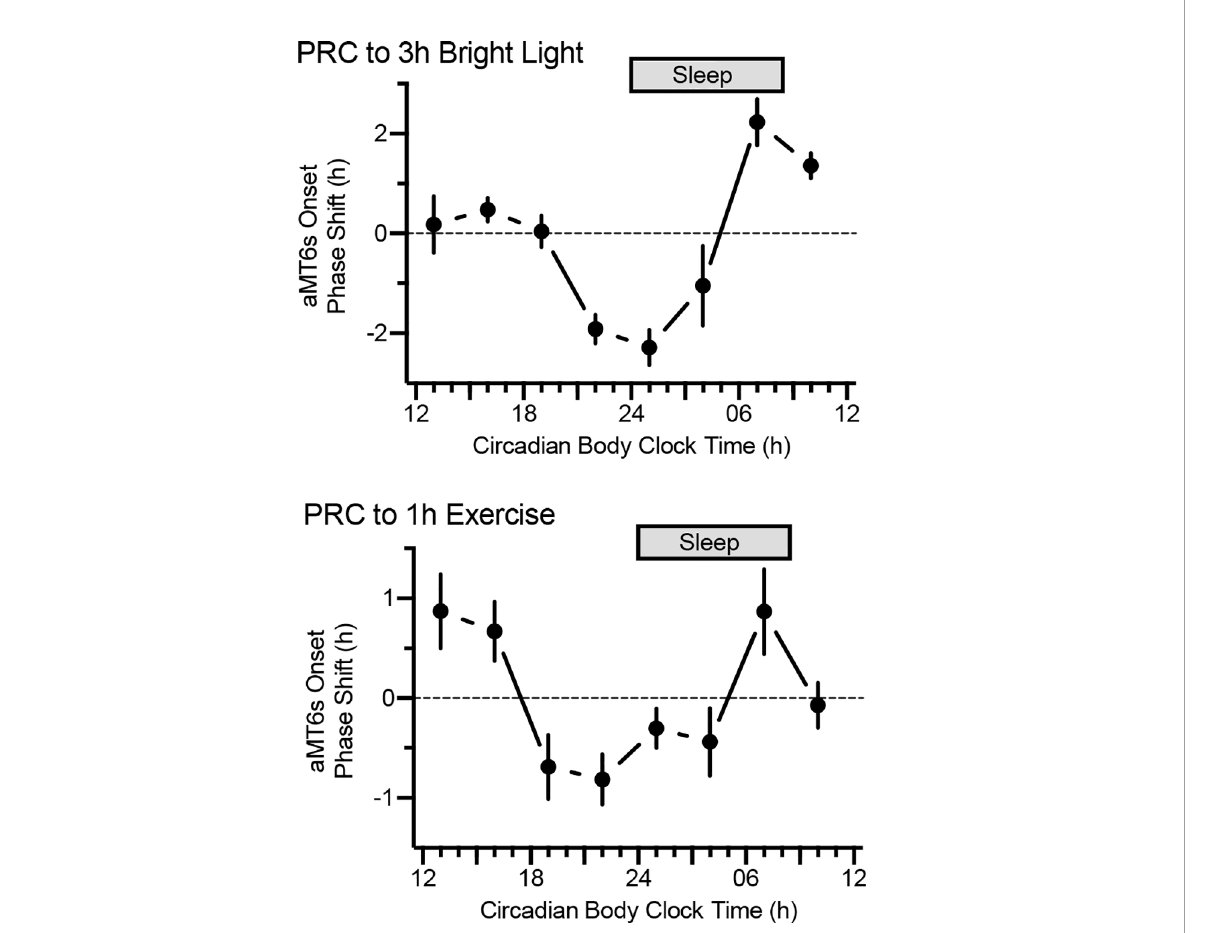
FIGURE 3 Phase-response curves to bright light (n = 105, top) and exercise (n = 101, bottom). By convention, phase advances and phase delays are denoted by positive and negative values on the ordinate, respectively. Participants followed the ultrashort sleep-wake schedule for 5.5 days, receiving light (3 h, 5,000 lux) or exercise (1 h, moderate) on 3 consecutive days. Shifts in aMT6 onset from baseline to end-of-study (y axes) depended on timing of the stimuli. Note: maximal phase delays for light and exercise occurred at 0100 h and 2200 h circadian body clock time,